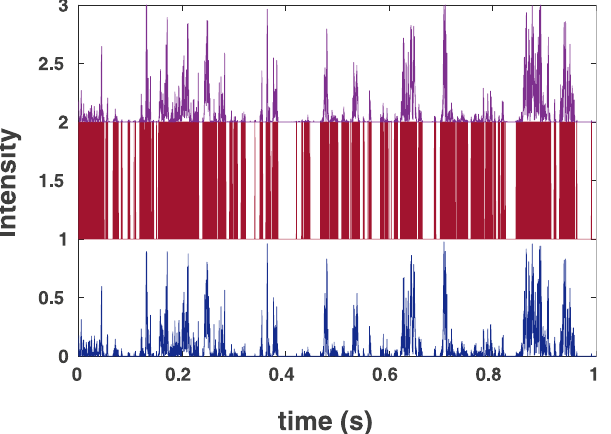
Figure 1. Simulation results for fluorescence intensities for the case of normal diffusion: (upper, purple) the original intensity trace I